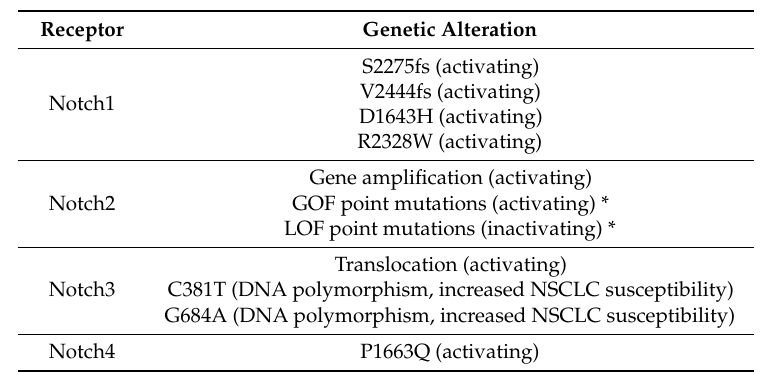
Table 1. Mutational status of Notch receptors in